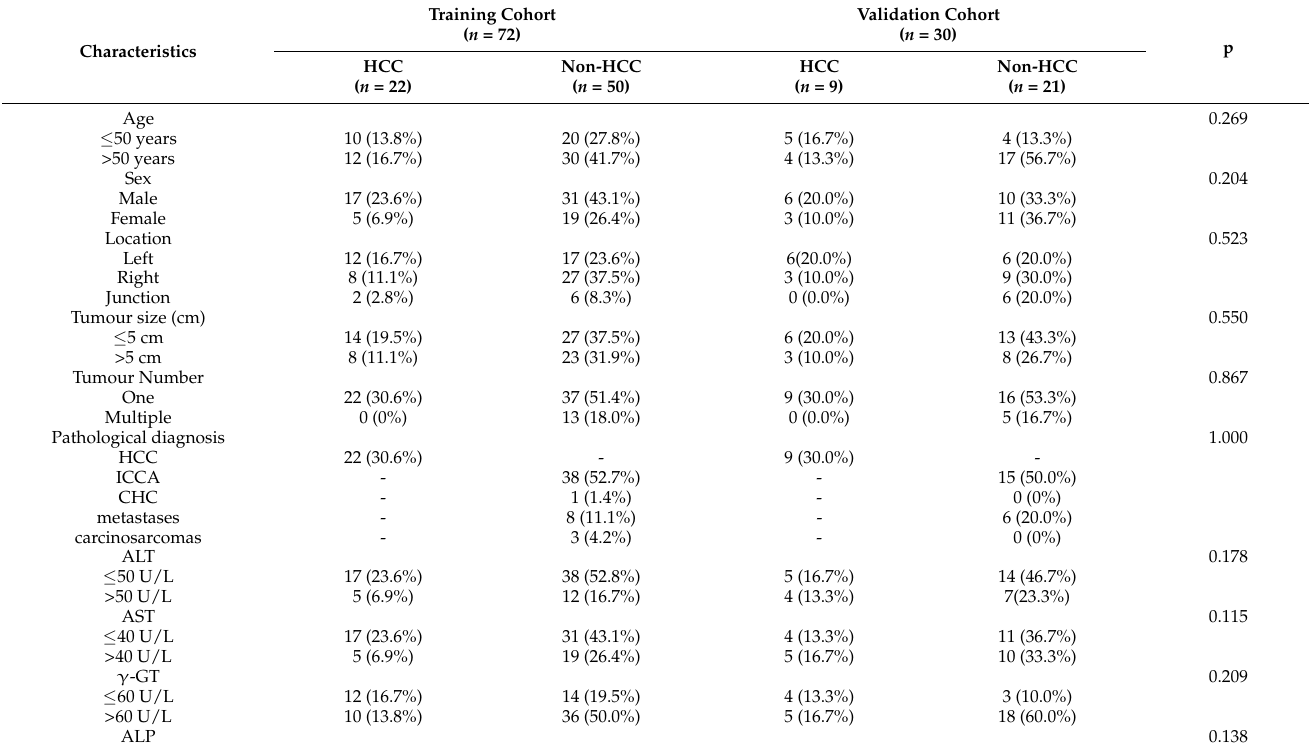
Table 1. Baseline Clinical Characteristics of LR-M